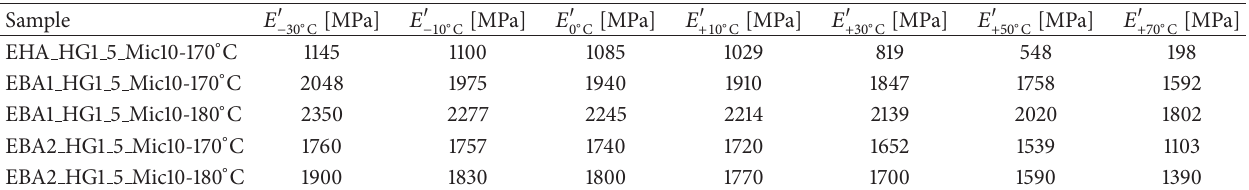
Table 3: Dynamic elastic moduli for self-healing formulation in the range of temperature between − 30 and 70 ∘ C.